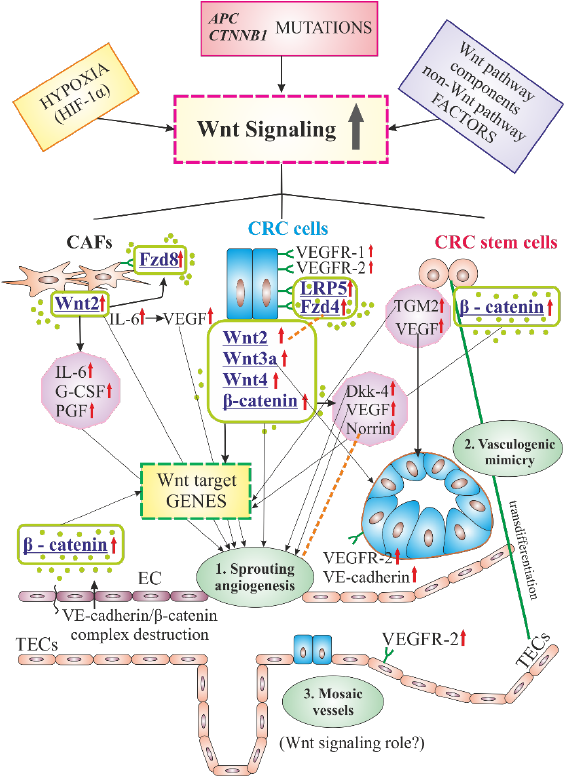
Figure 1. Angiogenesis-related functions of the Wnt/β-catenin signaling pathway in colorectal cancer (CRC). Schematic overview of the main components of the canonical and non-canonical Wnt signaling overexpressed ( ↑ ) in the main cells of the tumor (i.e., CRC cells, CRC stem cells, and cancer-associated fibroblasts (CAFs)). Various extracellular factors (e.g., Wnts) and cytoplasmic proteins (e.g., β-catenin) secreted by these cells play a stimulating (arrows) or regulating (dotted lines) role in angiogenesis. There are several other pro-angiogenic factors (e.g., VEGF, IL-6, Norrin) that interact with the Wnt pathway components to enhance angiogenesis in CRC. CRC stem cells can directly transdi ff erentiate into tumor endothelial cell (TECs) to form vascular-tube structures (vasculogenic mimicry). In the sprouting angiogenesis and vasculogenic mimicry, Wnt pathway-related mechanisms are well described. In turn, the role of Wnt signaling in mosaic vessel formation in CRC is poorly understood (for details see text). Abbreviations: APC—Adenomatous Polyposis Coli gene;